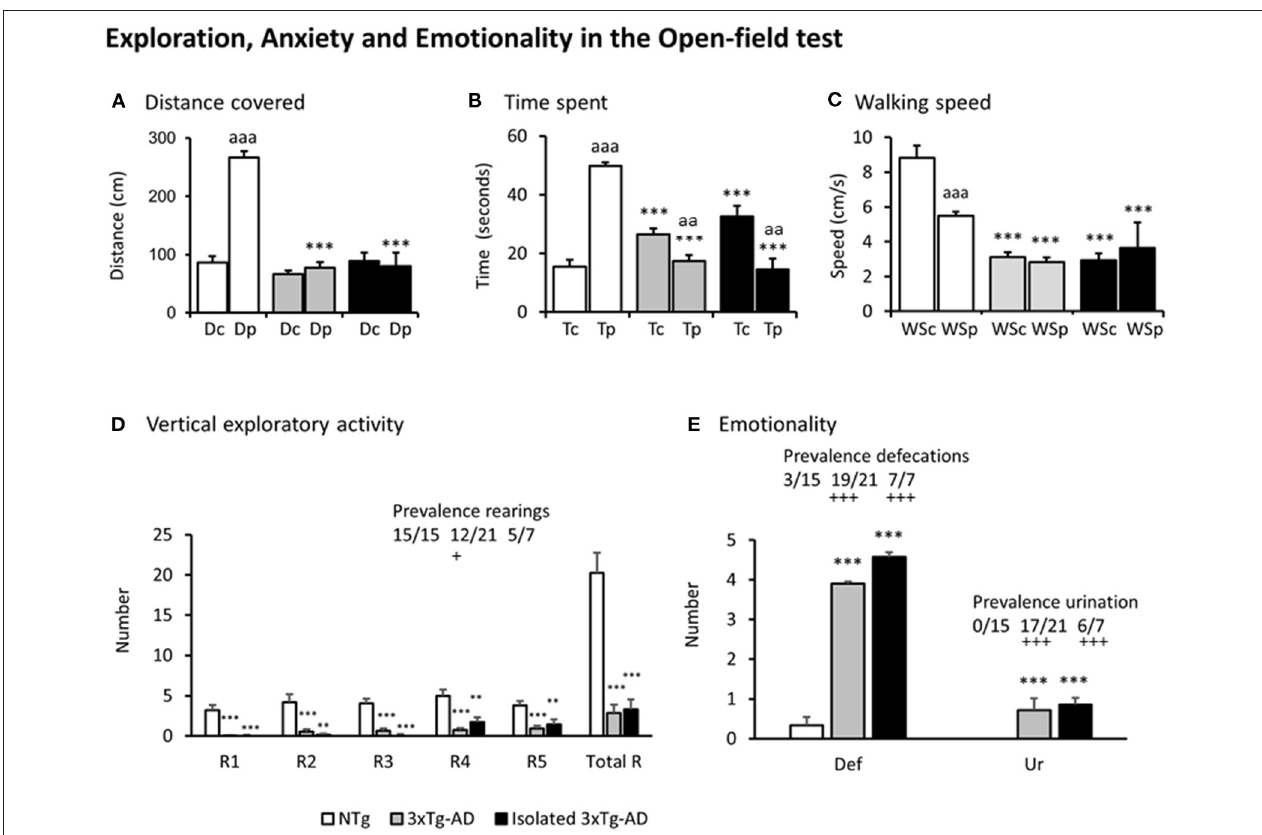
FIGURE 2 | Exploration, Anxiety, and Emotionality in the Open-field test. Results are expressed as mean ± SEM. (A) Distance covered, (B) Time spent, (C) Walking speed, (D) Vertical exploratory activity, (E) Emotionality. Abbreviations: Dc, distance in the center; Dp, distance in the periphery; Tc, time in the center; Tp, time in the periphery; WSc, Walking speed in the center; WSp, walking speed in the periphery; Rn, rearings at minute n; Total R, total number of rearings; Def, defecation boli; Ur, urination. Statistics: One-way ANOVA followed by post-hoc Duncan’s test, * p < 0.05, ** p < 0.01, *** p < 0.001 vs. the NTg mice; # p < 0.05. vs. the 3xTg-AD mice, Paired t -test, aa p < 0.01, aaa p < 0.001 vs. the same variable in the center of the open-field test. Fisher’s exact test, + p < 0.05 and + + + p < 0.001 vs. the NTg